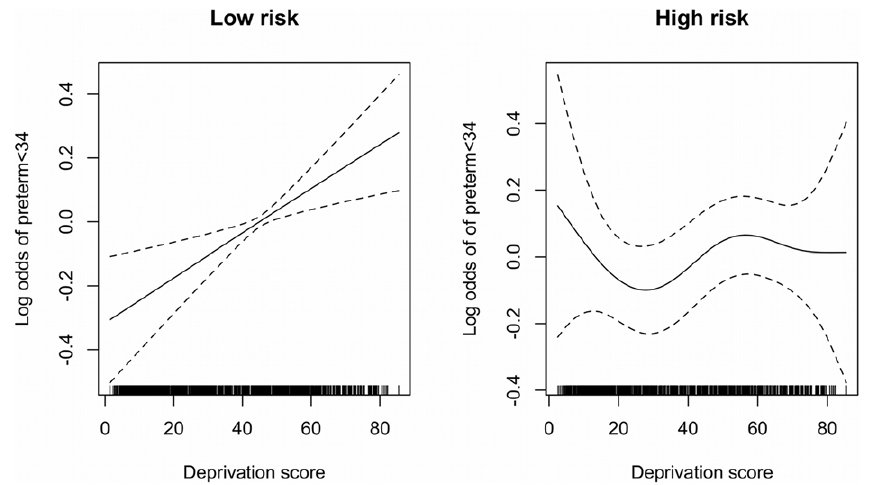
Figure 3. Generalized additive model assessing the relationship between risk of preterm delivery , 34 and deprivation score.